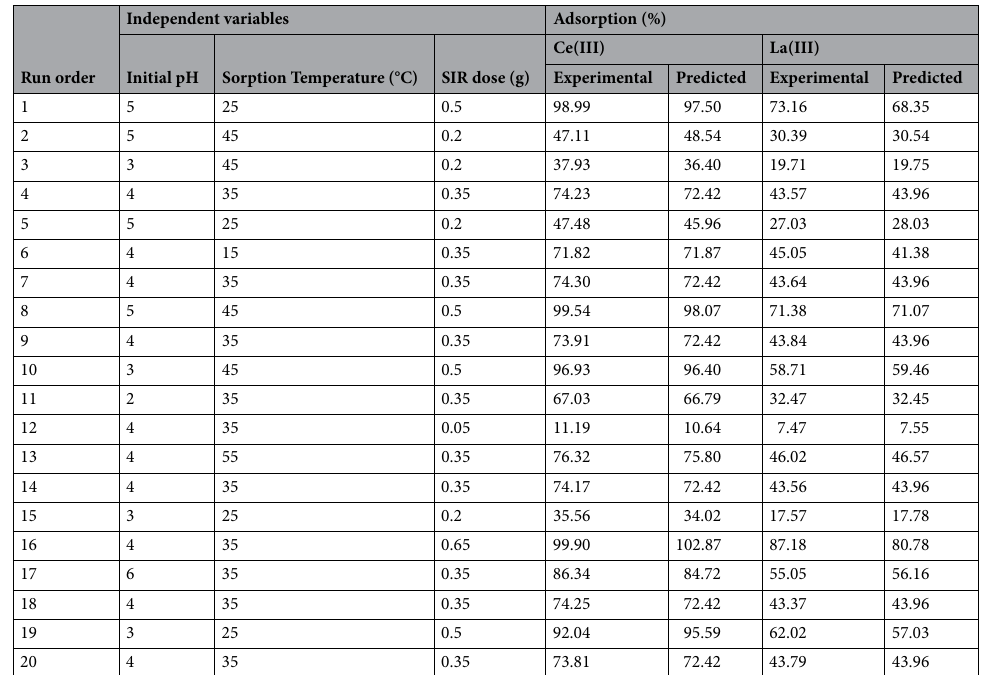
Table 2. Experimental plan network and average calculated percentage adsorption of Ce(ΙΙΙ) and La(ΙΙΙ)